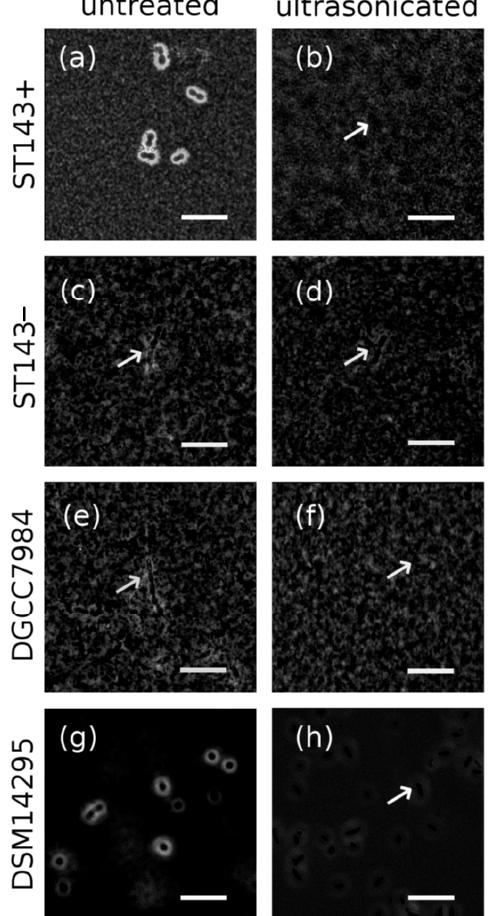
Figure 1. Microscopic images of the cell suspensions of S. thermophilus ST143 + ( a , b ), ST143 − ( c , d ), DGCC7984 ( e , f ), and W. cibaria DSM14295 ( g , h ) stained with India ink for CPS visualization, before ( left ) and after ( right ) ultrasonic treatment for CPS removal. Magnification: 1000 × , scale bar: 10 µ m. Arrows indicate microbial cell